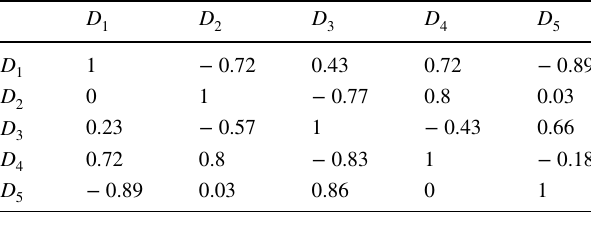
Table 1 The trust score ts ij of DMs in an